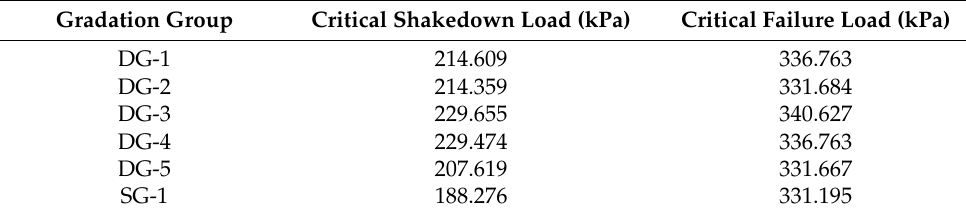
Table 4. Critical loads of six gradation groups of graded crushed stone.